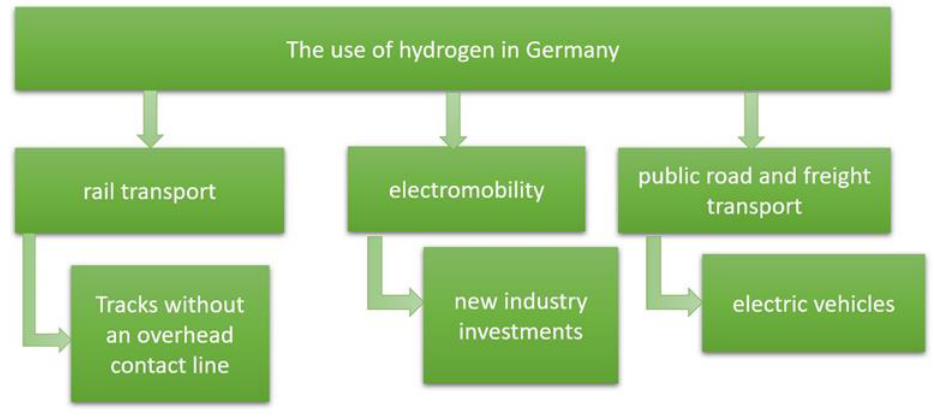
Figure 12. Utilization of hydrogen in Germany [78].